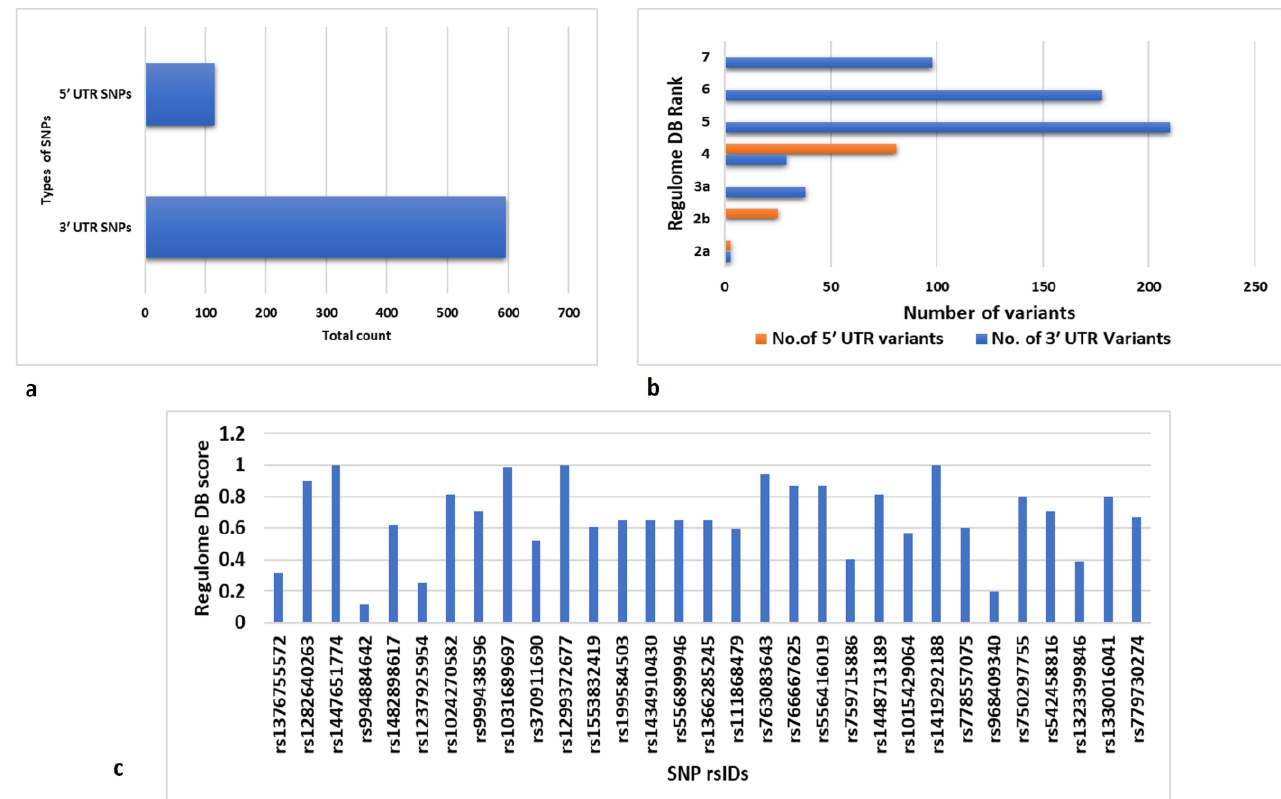
Figure 2. ( a ) Total count of 3 ′ and 5 ′ UTR variants of PRKCI recovered from Ensembl; ( b ) annotation and scoring of UTR SNPs obtained through RegulomeDB; ( c ) RegulomeDB scores of SNPs annotated as 2a and 2b. Table 1. Minimum free energy (MFE) of wild and mutant structures of mRNAs caused by 5 (cid:48) UTR SNPs.